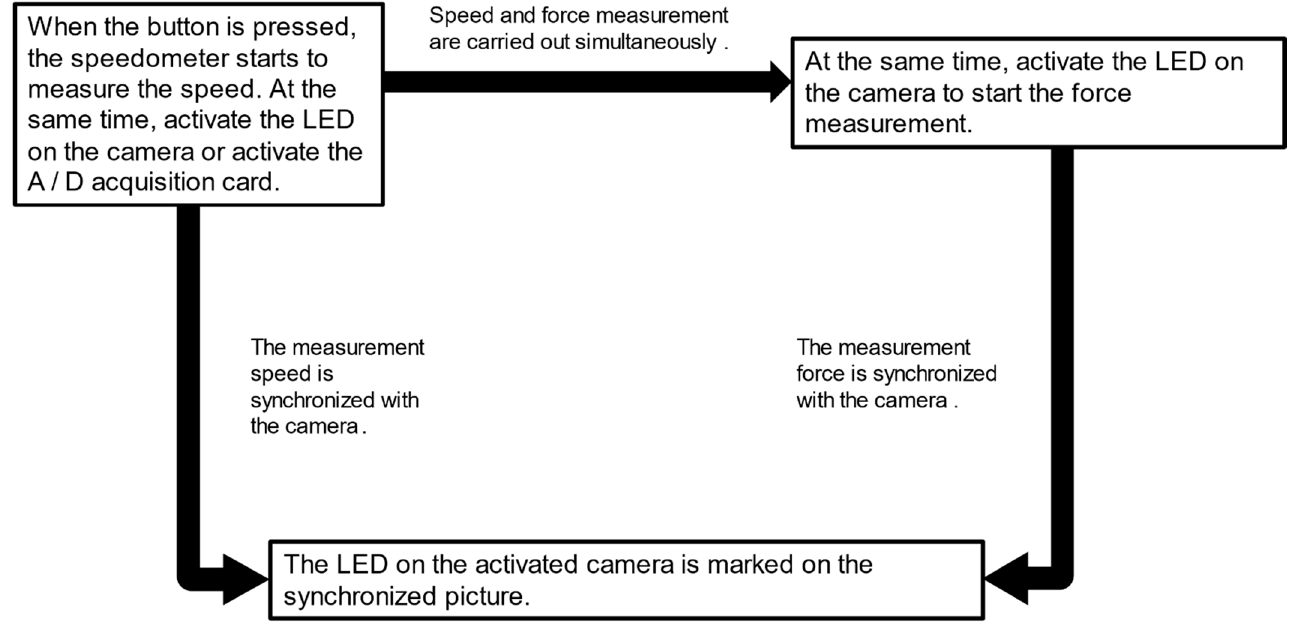
Figure 10. Schematic diagram of the experimental data testing process.